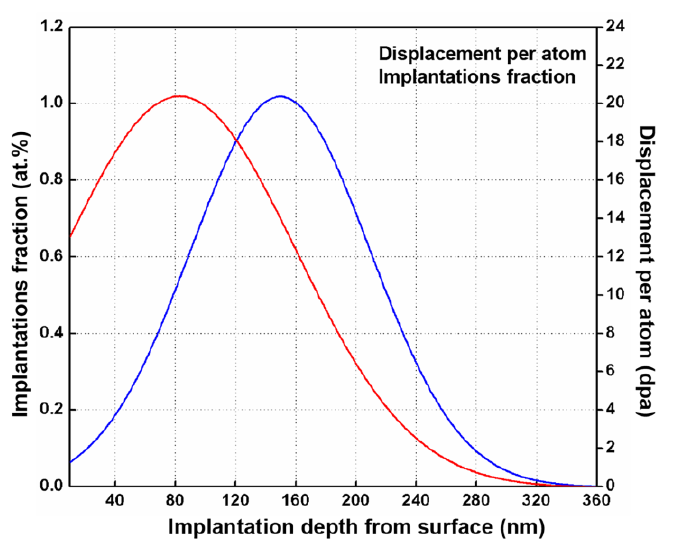
Figure 1. The profiles of damage (dpa) and implantation predicted by SRIM08 code. The red line indicates the change of dpa with indentation depth, and the blue line indicates the change of implantation fraction with indentation depth.